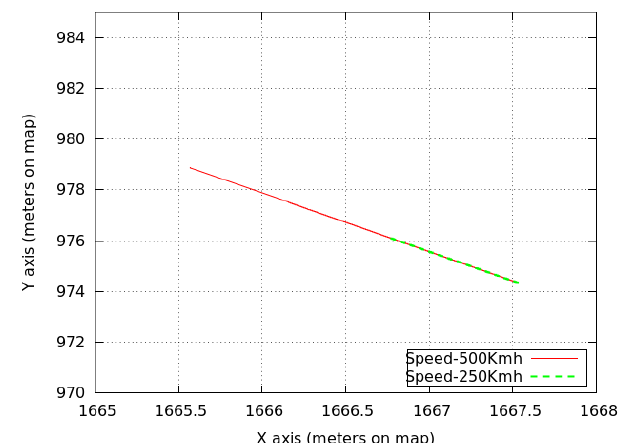
Figure 14. Distance traveled with speed